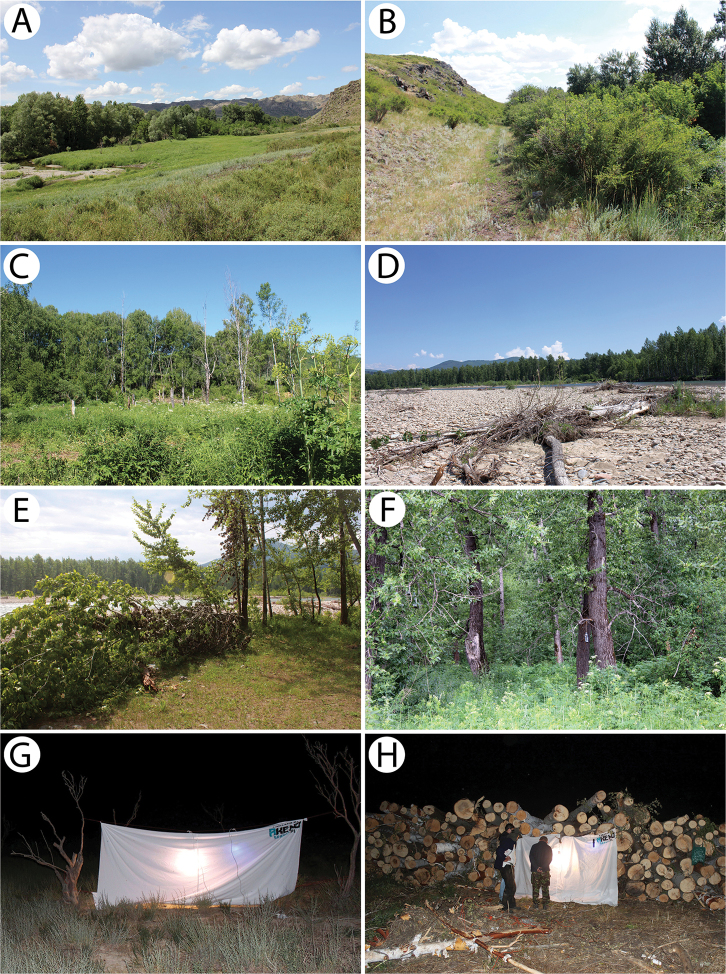
Field photos of habitats of typical Kazakh cerambycid species and some methods used: A general view on Sibinka River valley, the habitat of several collected species B pea shrubs on stony hills in Sibinka River valley, the habitat of Stenocorusminutus and AnoplisteshalodendrihalodendriC mountain deciduous grove in Bykovo environs, the habitat of numerous collected species D general view on mountain deciduous forest along the Khamir River in Putinsevo environs, the habitat of numerous collected species E river bank with poplar windfalls, the habitat of SaperdaalbertiF wine trap in poplars forest, the habitat of inter alia Macrolepturathoracica, Rhaphumagracilipes and ExocentrusstierliniG attracting insects to artificial light source in Artemisia-desert habitat H attracting insects to artificial light source at the edge of a mountain deciduous forest.